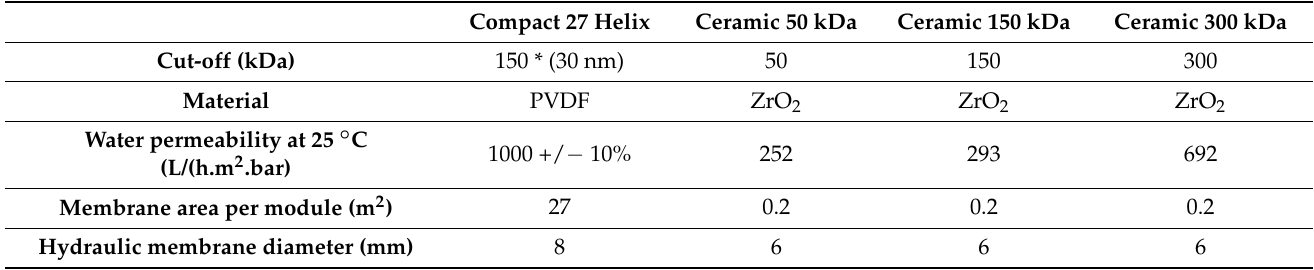
Table 1. UF membranes applied in liquid Digestate